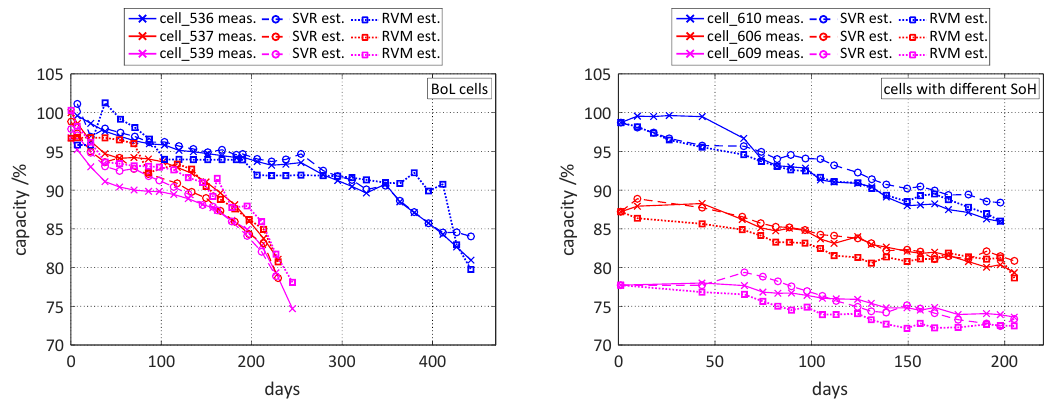
Figure 10. Batch model results validated on data only from life cycle measurements with BoL cells ( left ) and on a updated data set by measurements from vehicle durability tests on the ( right ) graph.